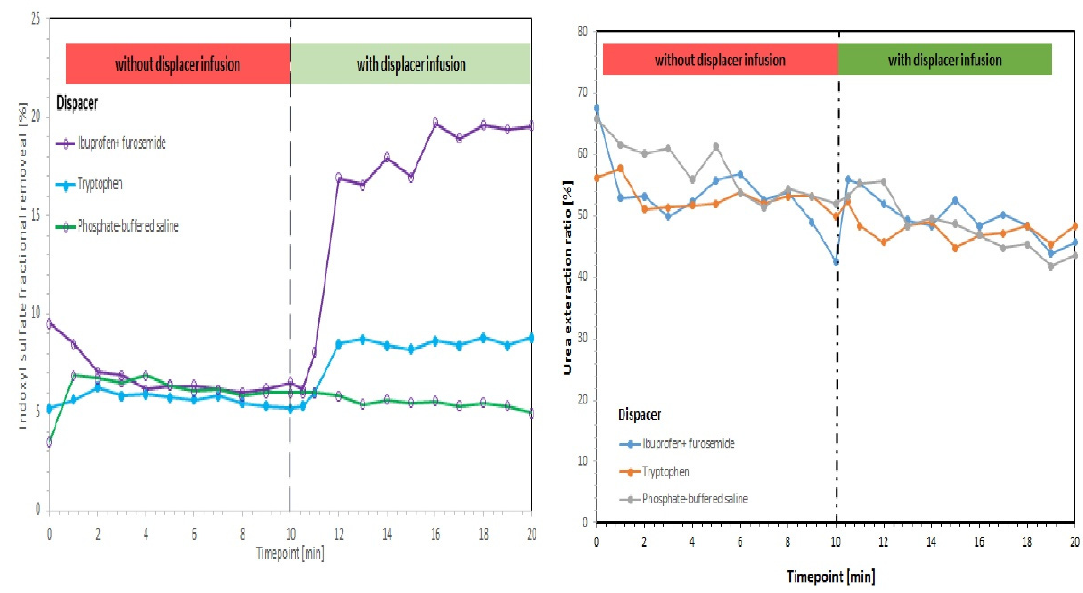
Figure 11. Human whole blood experiments with a competitive binding strategy showing IS removal ( left ) and urea removal ( right ) (adapted from [93]).